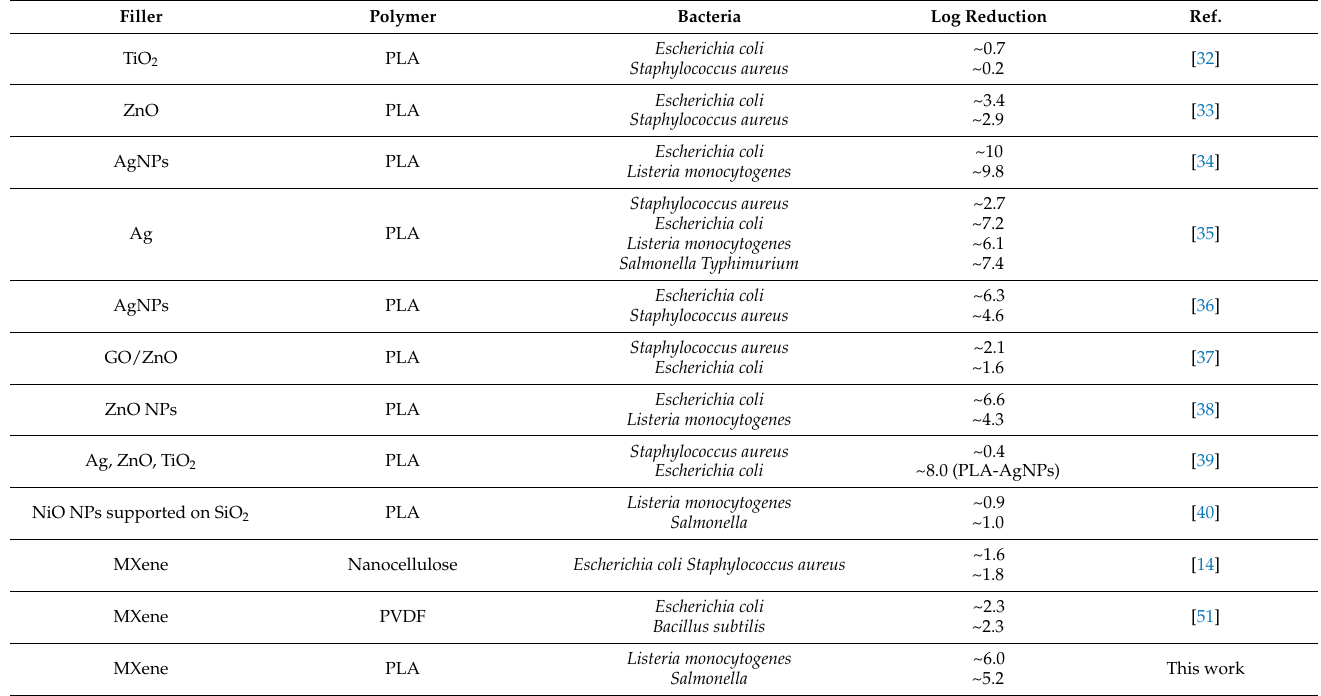
Table 4. Polymeric matrix/filler antibacterial systems reported in the literature having either PLA as the polymeric matrix or MXene as the filler.